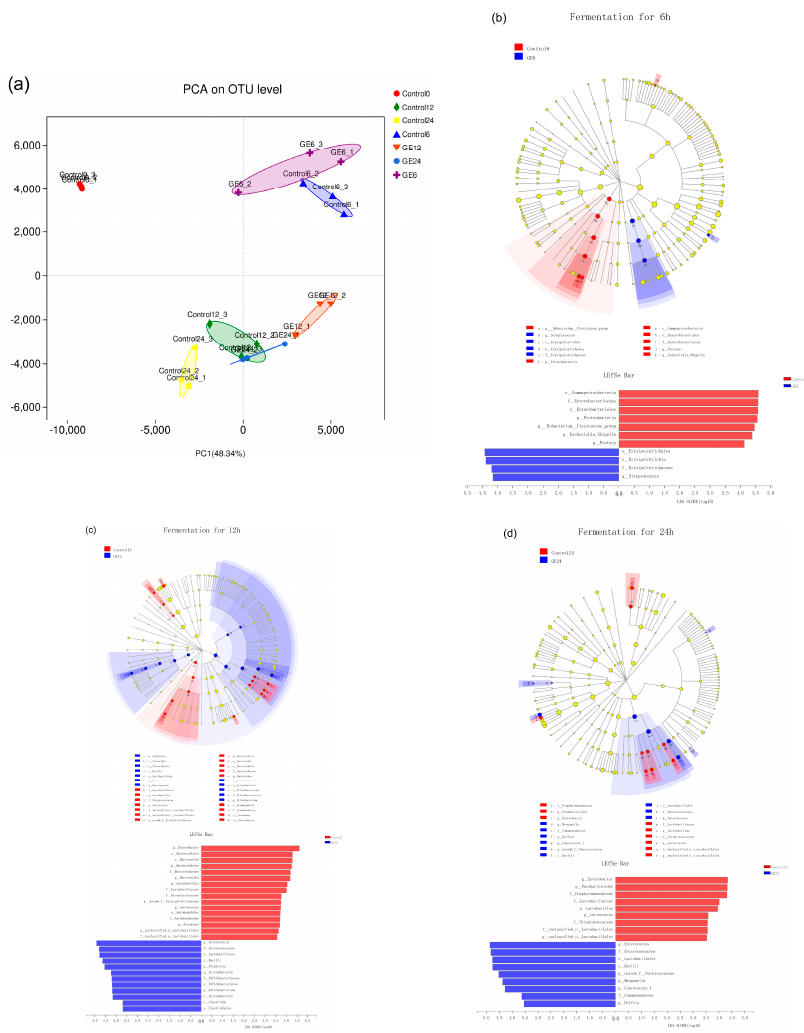
Figure 1. Relative abundance of the gut microbiota: ( a ) phylum level; and ( b ) genus level. Control0, Control6, Control12, and Control24 indicate fermentation of water at 0, 6, 12, and 24 h; GE6, GE12, and GE24 indicate fermentation of ginger extract (GE) at 6, 12, and 24 h.